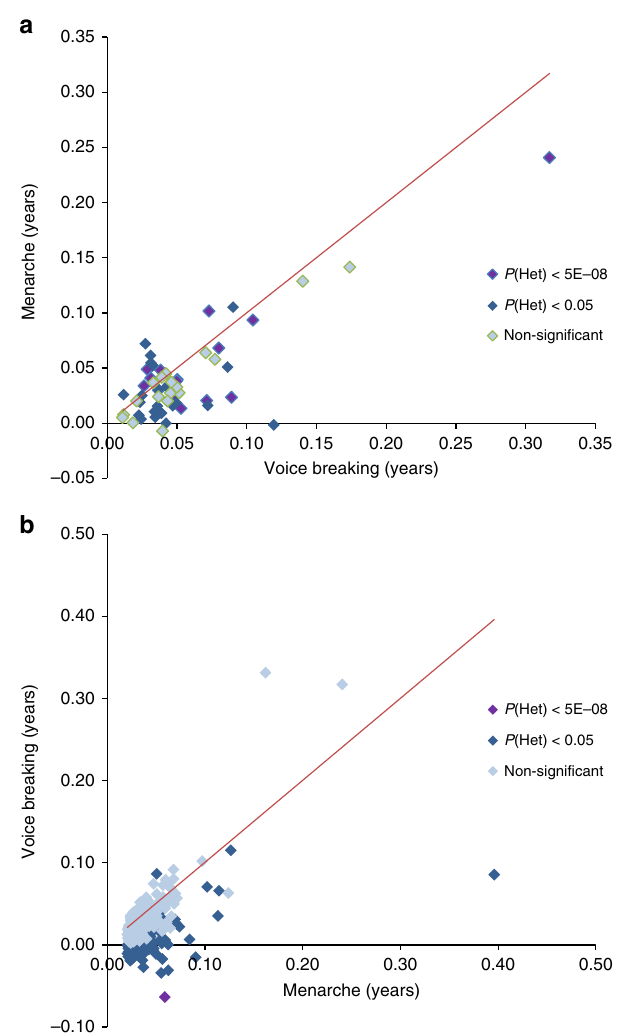
Fig. 2 Scatterplots comparing variants for effect size on age at menarche and age at voice breaking. a Scatterplot for independent signals identi fi ed in voice breaking meta-analysis (23andMe and UK Biobank) in MTAG. X-axis depicts SNP effect on age at voice breaking in years from 23andMeGWAS; y-axis shows effect on AAM. b Scatterplot for known AAM loci depicting effect size for menarche ( x -axis) and age at voice breaking (y-axis). Signals are colour-coded based on heterogeneity P